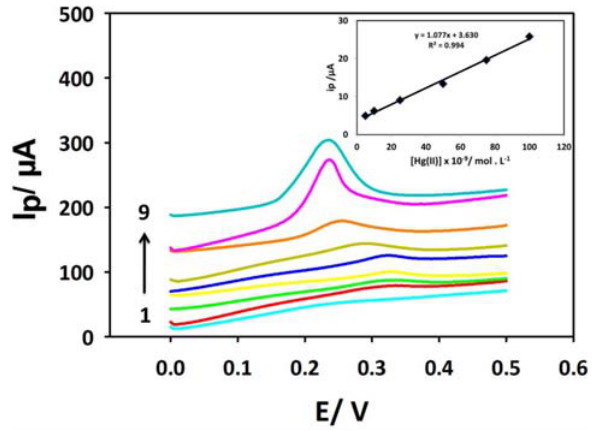
Figure 11: Square wave anodic stripping voltammograms (SWASVs) in 0.1 mol/L acetate buffer, pH 5.5, containing 1) 0.0,